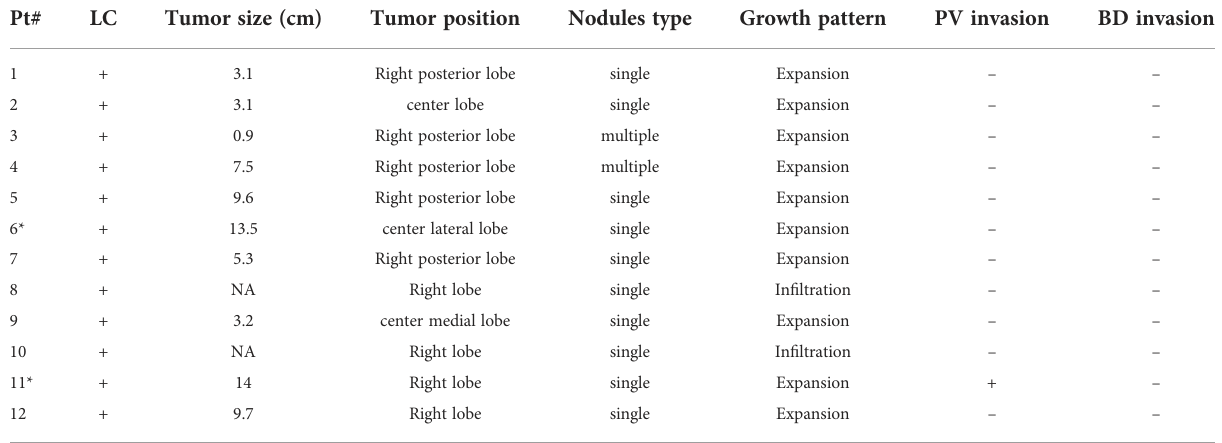
TABLE 5 Tumor features of 12 HCC patients associated with